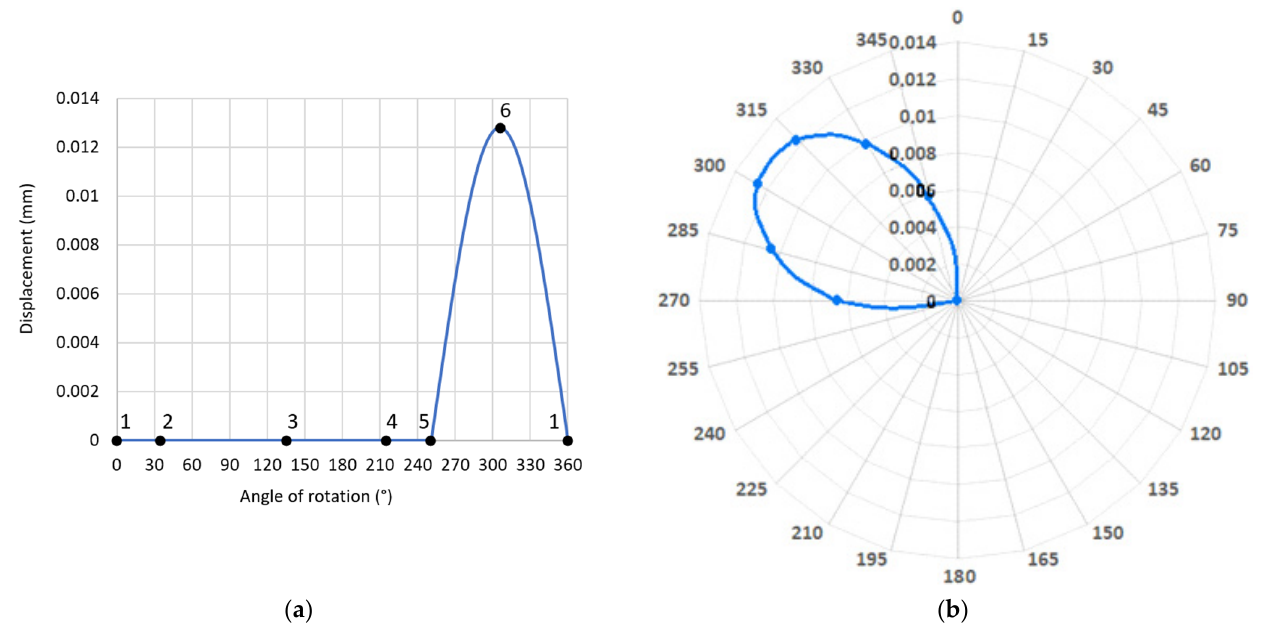
Figure 3. Graphs showing the displacement path of the sensor stylus presented in: ( a ) Cartesian coordinates; ( b ) polar coordinates (support offset x = 0.017 mm, eccentricity e = 0.030 mm, measurable eccentricity w = 0.013 mm).